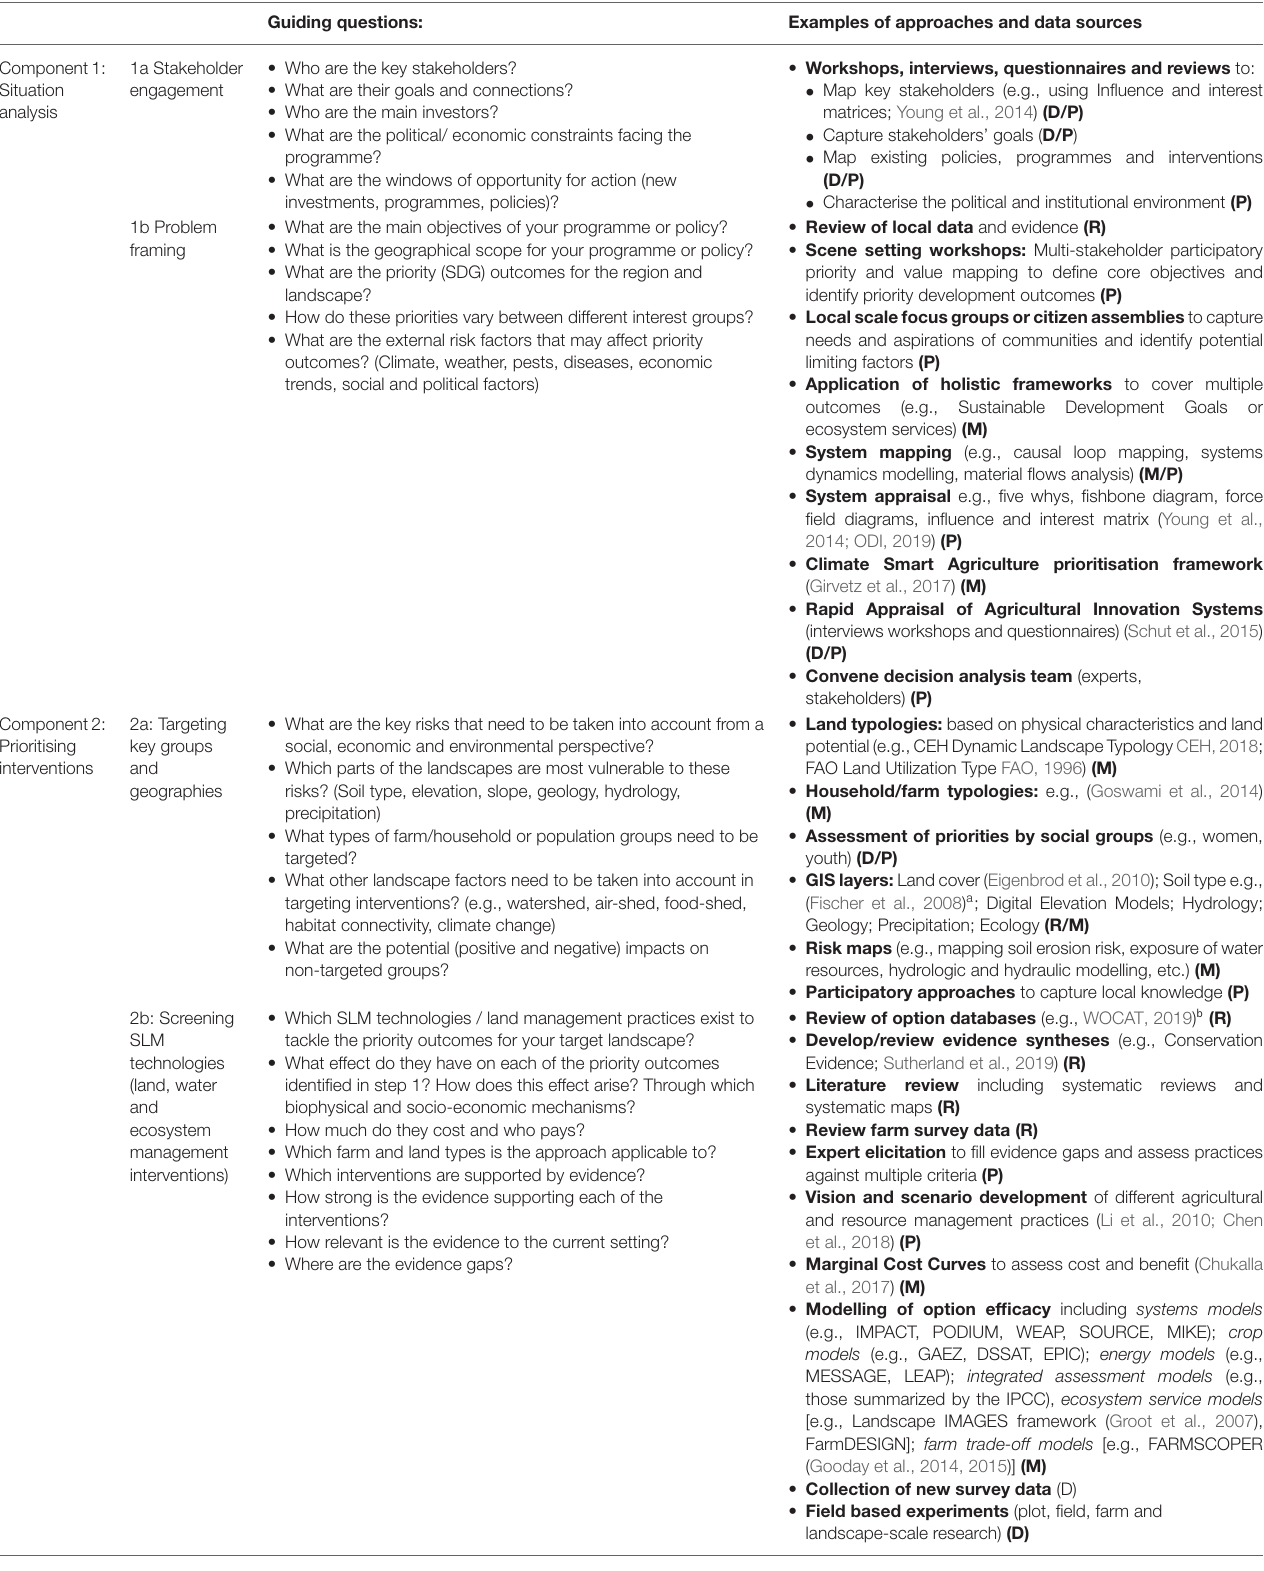
TABLE 3 | Proposed decision support framework for knowledge brokering in integrated landscape management. Guiding